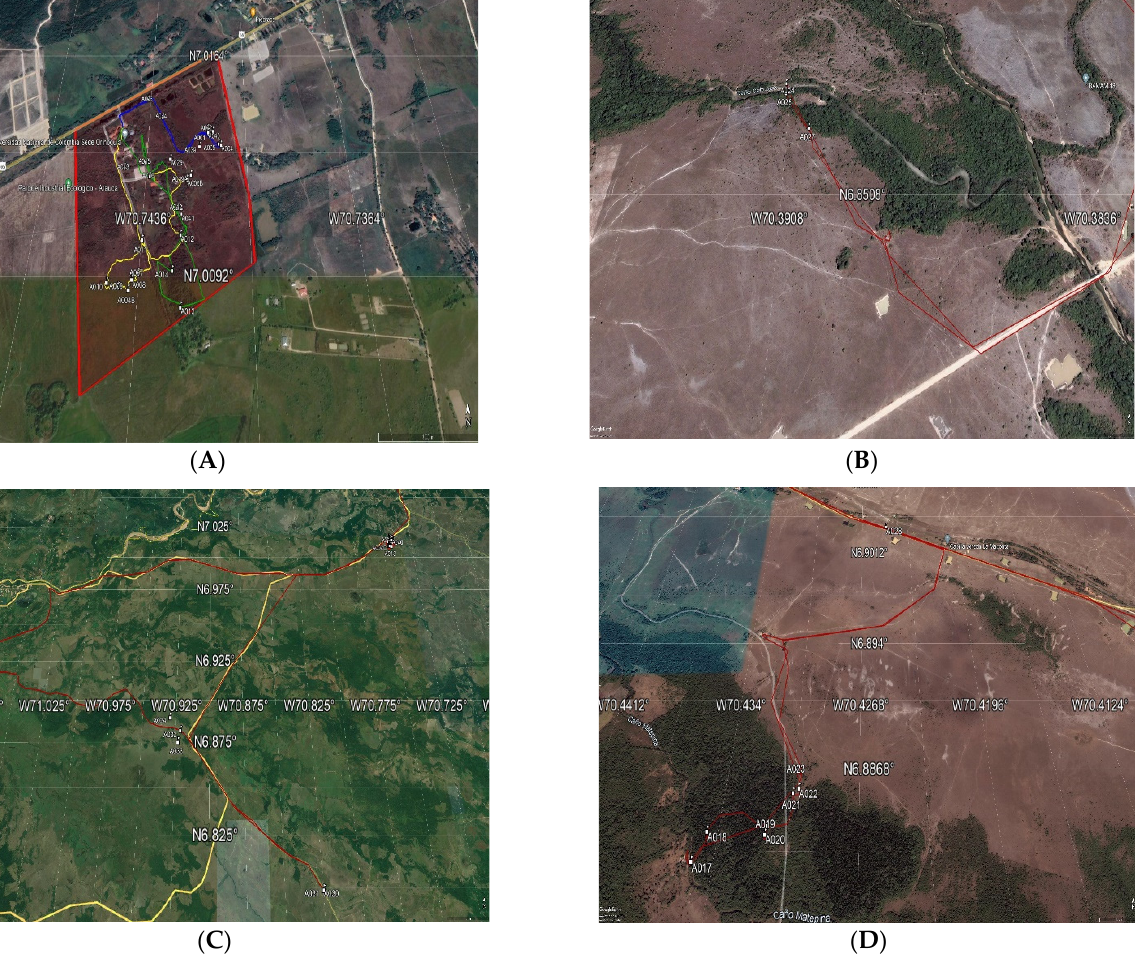
Figure 2. Some of the transects made through the “montane forests” ( A , C ), gallery forests ( B , D ) and open savannah ( C ) ecosystem. Red, blue, green and yellow lines were the transects covered in different moments.